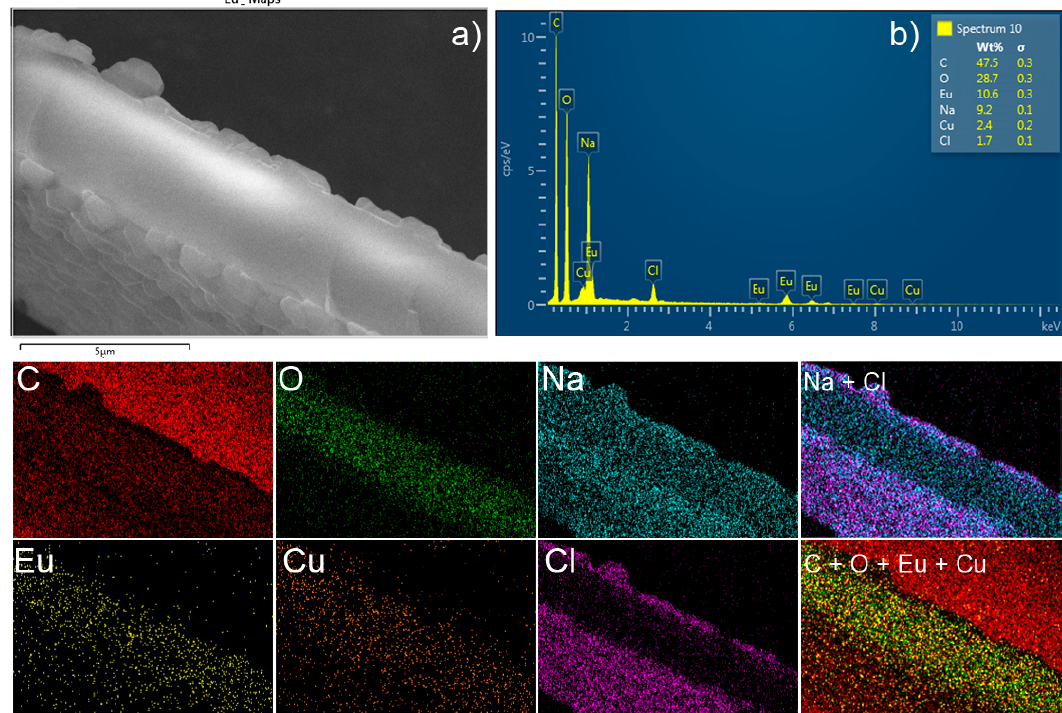
Figure 8. ( a ) SEM micrography, ( b ) EDX spectra and elemental maps of Eu 3 + / PSA after contact with Cu 2 + . The right-hand figures represent the combined elemental maps; for the sake of clarity, the elemental maps of counterions (Na and Cl) are represented in a separated figure.